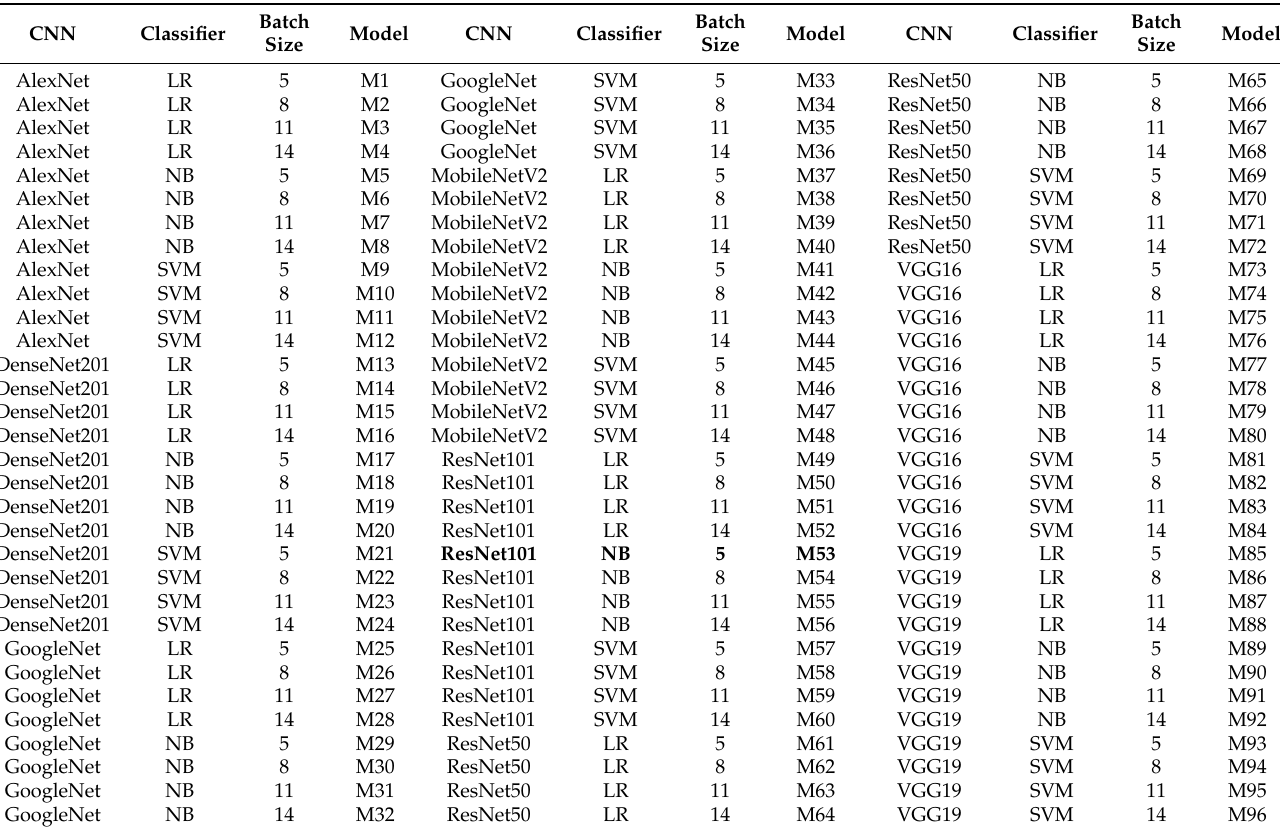
Table A1. The 96 combinations of investigated models with abbreviation are listed